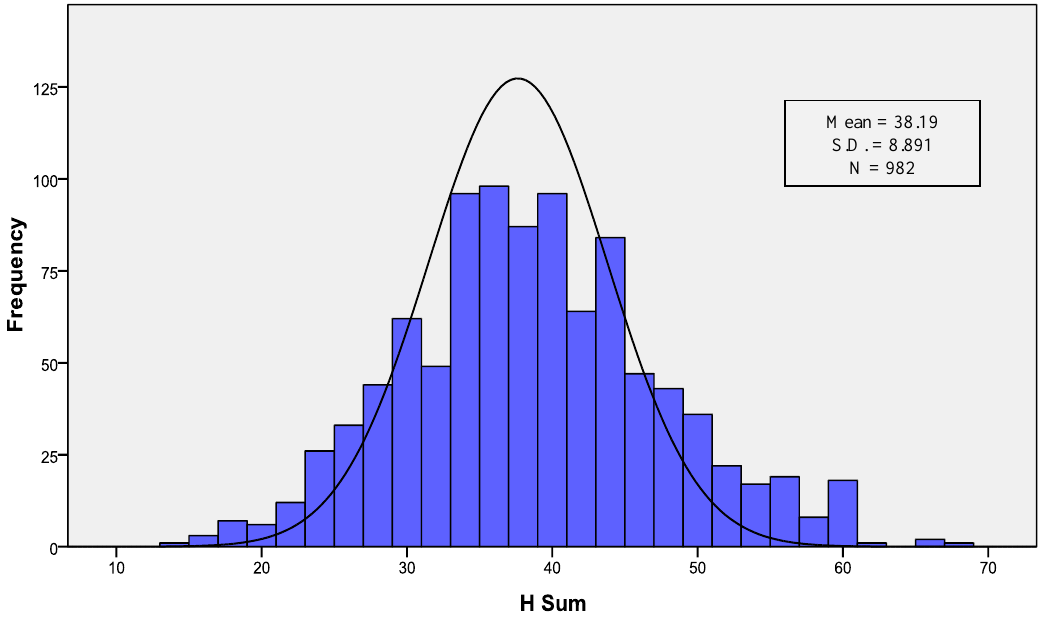
Graph 1. H-Scale sum distribution, histogram with a normal curve. Figure 1. H-Scale sum distribution, histogram with a normal curve.